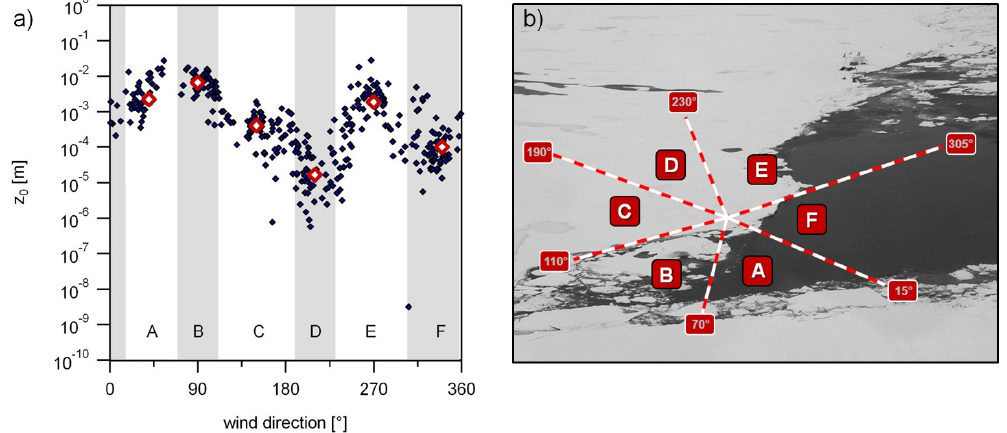
Fig. 2. (a) Roughness length z 0 in six wind direction sectors A–F; red diamonds represent median z 0 values in each wind sector. (b) Aerial view of the measurement site and overlay of the six wind